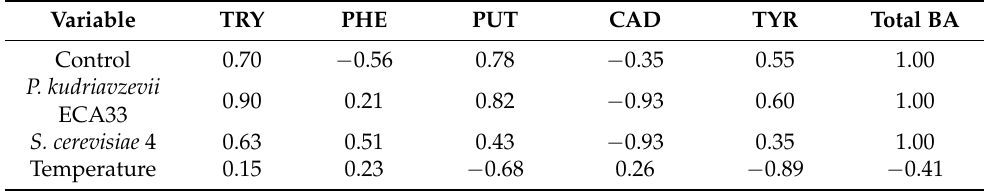
Table 3. Pearson Correlation Coefficient * of each amine against total biogenic amines (Bas) and temperature, found in model cocoa fermentation systems.